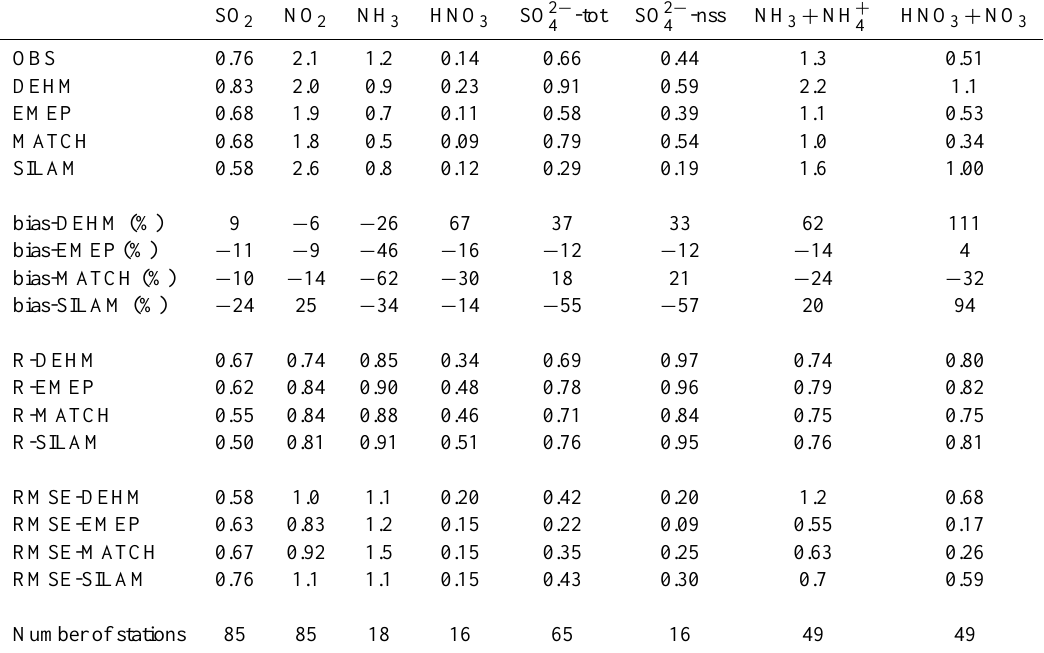
Table 3. Evaluation of modelled air concentrations of sulfur and nitrogen gaseous and aerosol species using observations from the EMEP measurement network (http://www.emep.int) for the years 2000–2010. Unit: µg ( S / N ) m − 3 . SO